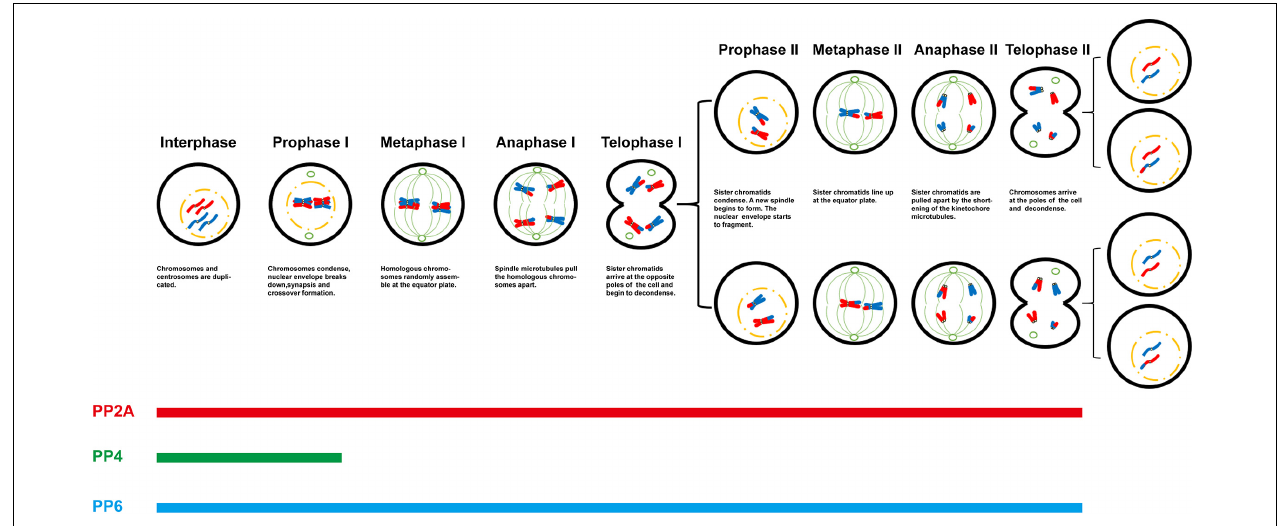
FIGURE 1 | Role of PP2A-like protein phosphatases in meiotic progression.